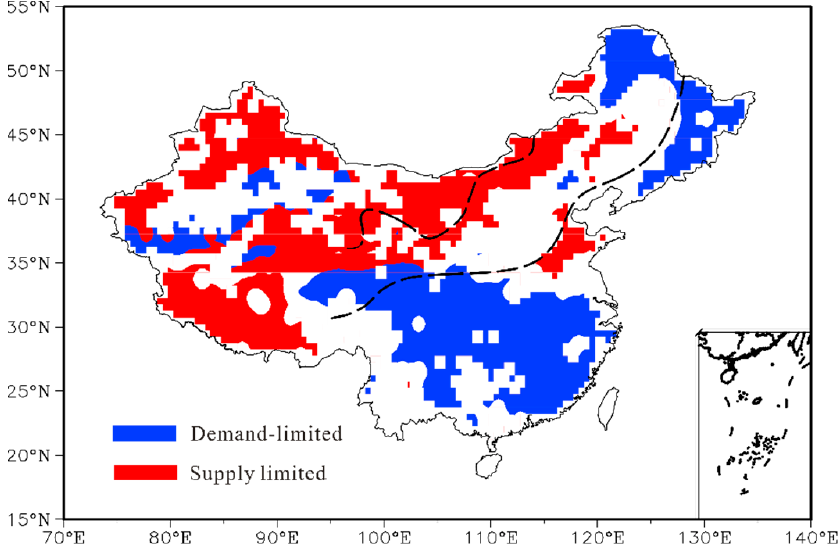
Figure 7. The spatial pattern of ET regimes in China during 1982–2011.